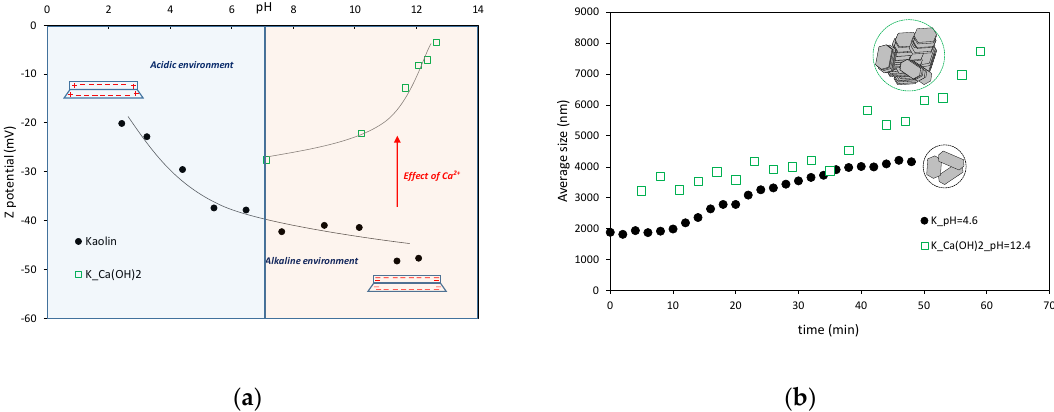
Figure 4. ( a ) Effects of pH and Ca(OH) 2 on the surface charge of kaolin suspensions (after [14]); ( b ) Evolution of the average floc size of kaolin suspensions (after [14]).